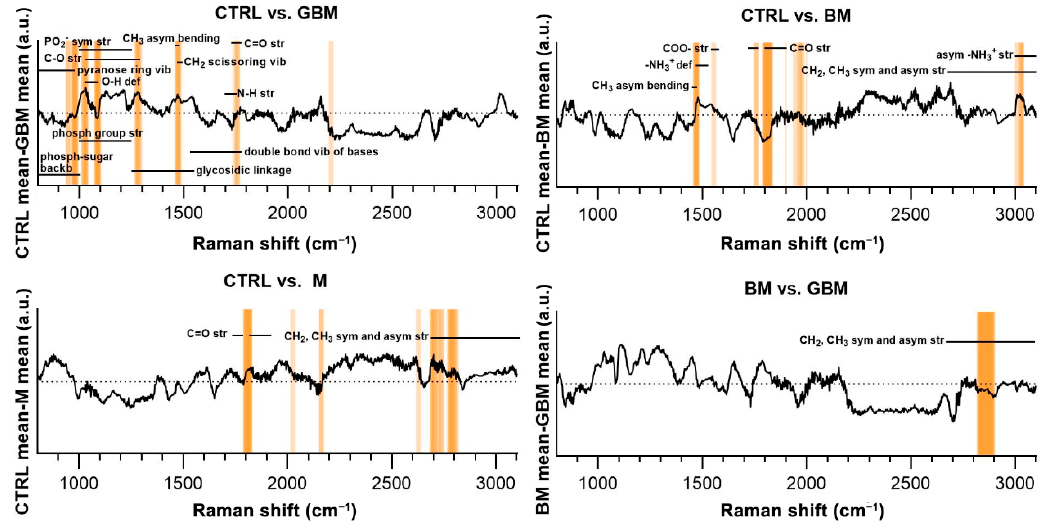
Figure 7. Subtraction spectra for the pairwise comparisons. Subtraction spectra were produced by subtracting the mean signal intensities for the groups compared. Spectral regions having a higher-than-average contribution to significant PCs were marked with orange bars. The more saturated a bar is, the more that region is represented on the selected PCs. The dotted horizontal line represents zero difference at y = 0. (Abbreviations: asym, asymmetric; backb, backbone; def, deformation; phosph, phosphate; str, stretching; sym, symmetric; vib, vibration).